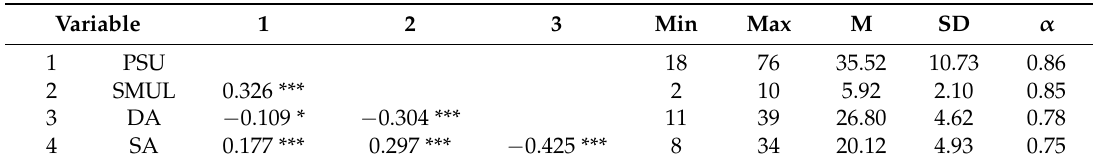
Table 1. Pearson product–moment correlations, means, standard deviations, and internal consistencies of scales and